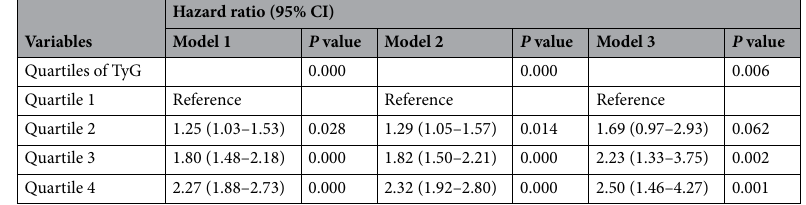
Table 3. Cohort analysis of the association between the baseline TyG index and the incidence of hyperuricemia. CI confidence interval. Model 1: no adjustment; Model 2: adjusted for age, gender. Model 3: adjusted for all the factors in model 1 and HDL-C, LDL-C, BMI, eGFR, 24hTP, SBP, DBP, HbA1c.